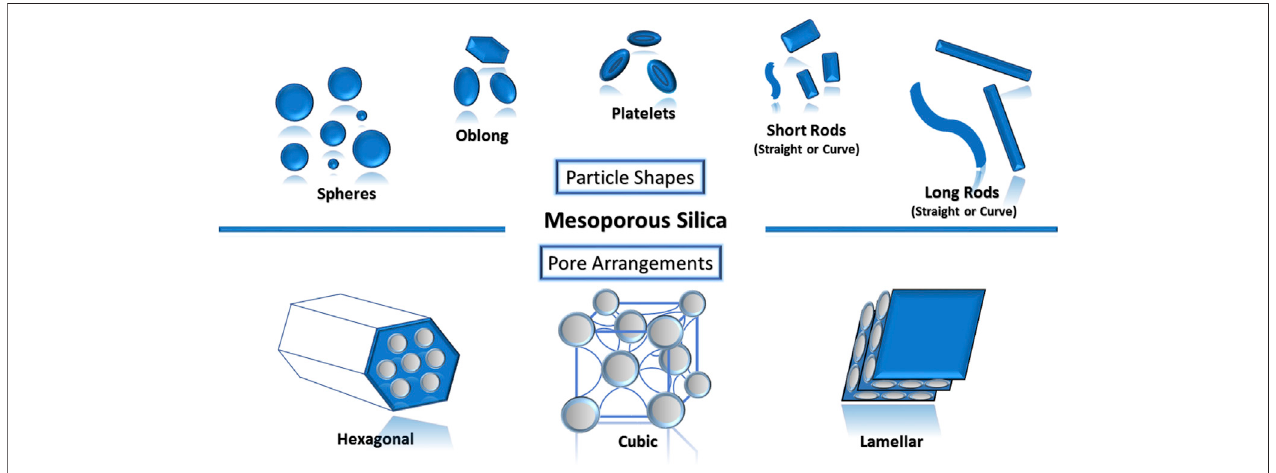
FIGURE 1 | Various types of mesoporous silica nanoparticles can be designed based on the intended purpose.